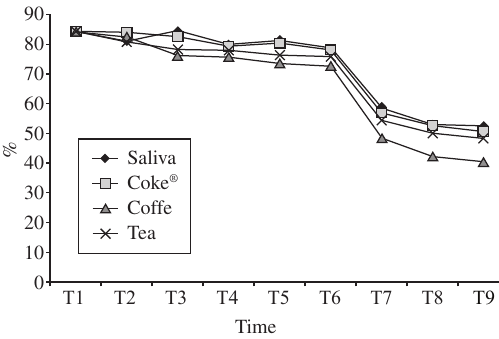
Figure 2. Translucency of composite resin without surface sealant in func- tion of